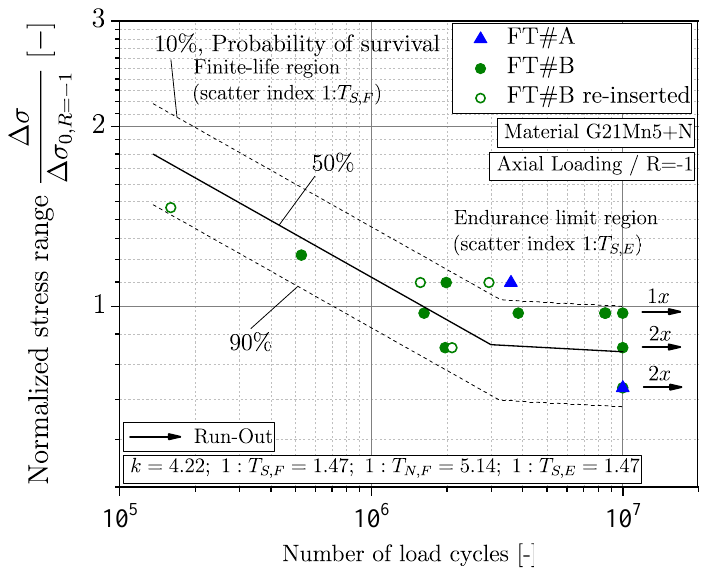
Figure 14. Evaluated S-N curve of the investigated large-scale specimens at R = − 1. Failure type A (FT#A), and failure type B (FT#B).